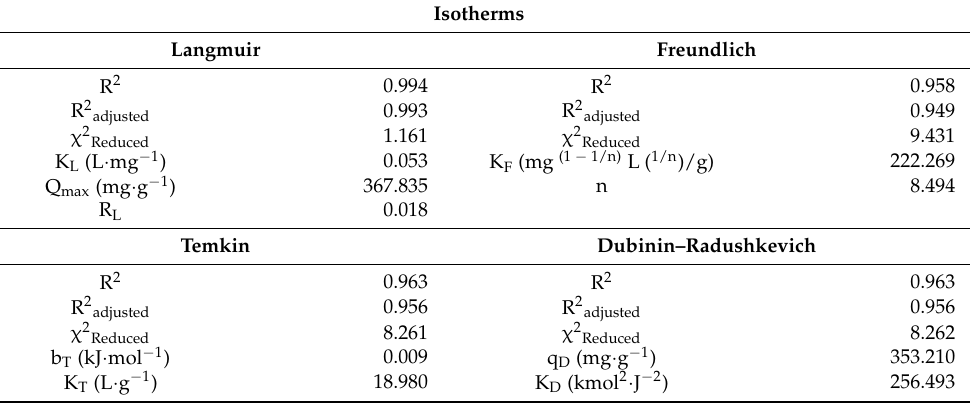
Table 4. Parameters for modeling isotherms of MeO adsorption on MO C-ZnCl